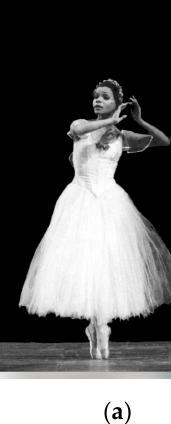
Figure 7. ( a ) Caridad Martinez in Les Silphides at the Teatro de Bellas Artes Ciudad de México. 1970-e. Photographer Roberto Aguilar. Published with the kind permission of Caridad Martinez; ( b ) Lázaro Carreño and Caridad Martínez in the Plásmasis .1970. Published with the kind permission of Lazaro Carreño and Caridad Martínez .